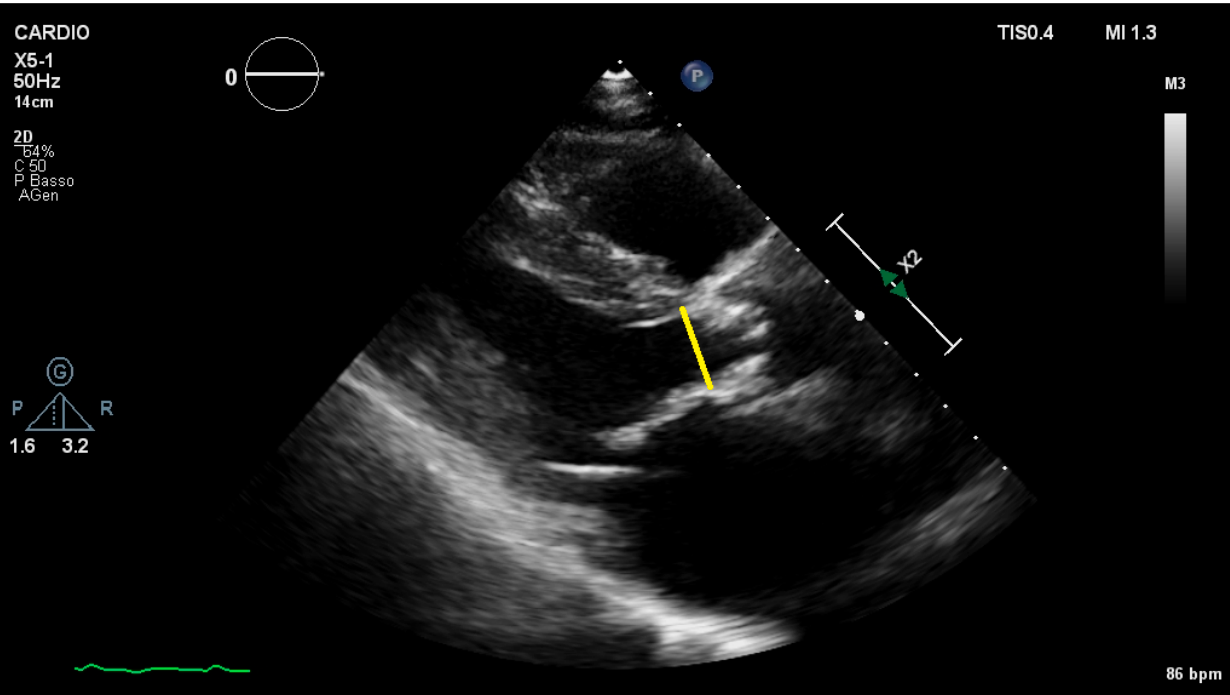
Figure 2. Measurement of the diameter of the Left ventricular outflow (yellow line) from the parasternal long-axis view, during systole, directly below the base of the aortic leaflets, and from the internal surfaces of the interventricular septum and the posterior aortic wall.